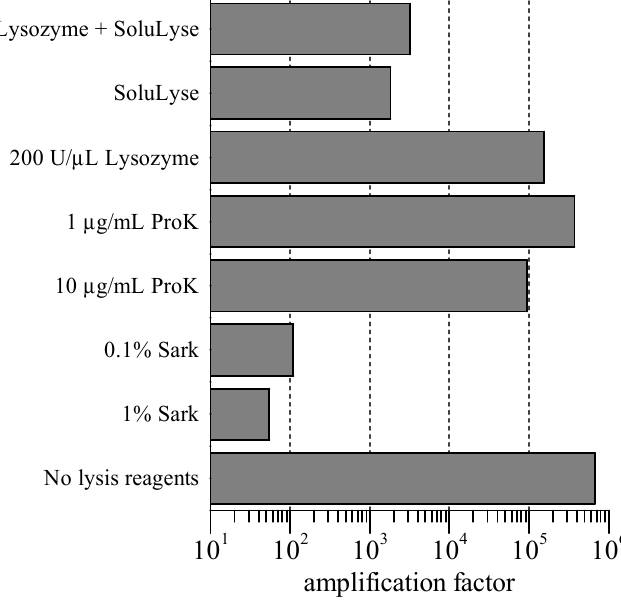
Figure 2. Inhibition of 50-µL Multiple displacement amplification (MDA) reactions by lysis reagents. Amplification factor was calculated by dividing the amount of amplified DNA, as quantified via PicoGreen assay, with that of the starting template (50 pg). The MDA reaction with 0.1% SDS yielded an amount of product (<10 pg/µL) that could not be detected within the limits of the PicoGreen assay, meaning that its amplification factor was below 10. Sark and ProK refer to sarkosyl and proteinase K, respectively. Error bars are not shown on this figure but are approximately 10% of each